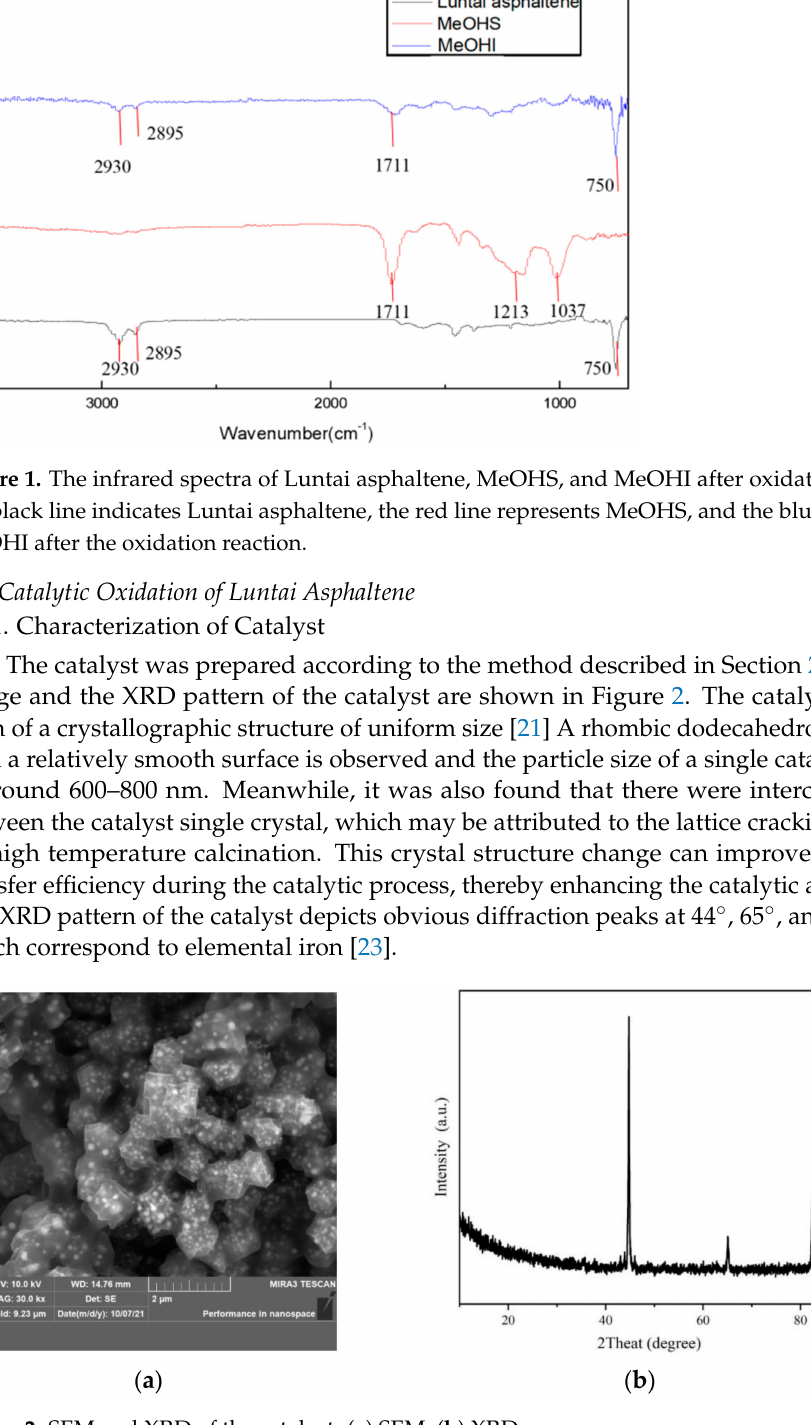
Figure 2. SEM and XRD of the catalyst. ( a ) SEM; ( b )